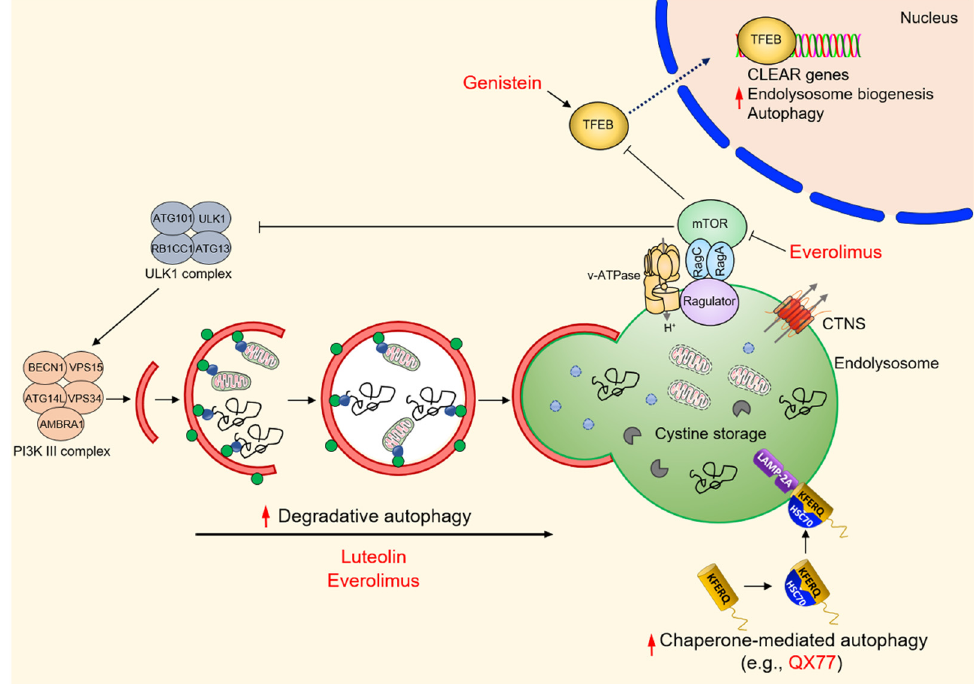
Figure 5. Summary of emerging therapeutic strategies targeting autophagy pathways in cystinosis.